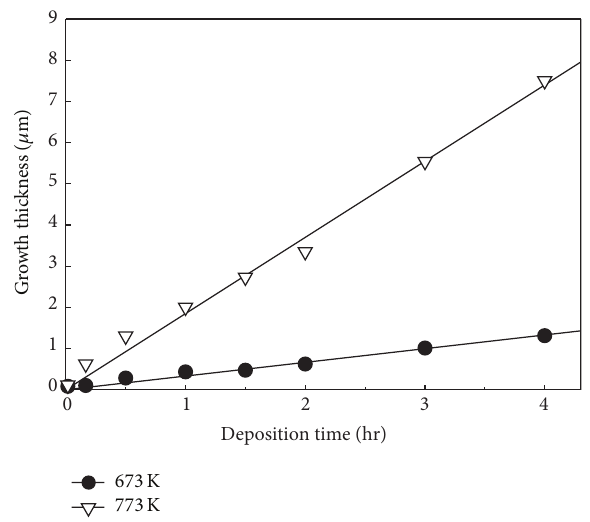
Figure 1: Thickness of TiO 2 films as a function of deposition times.